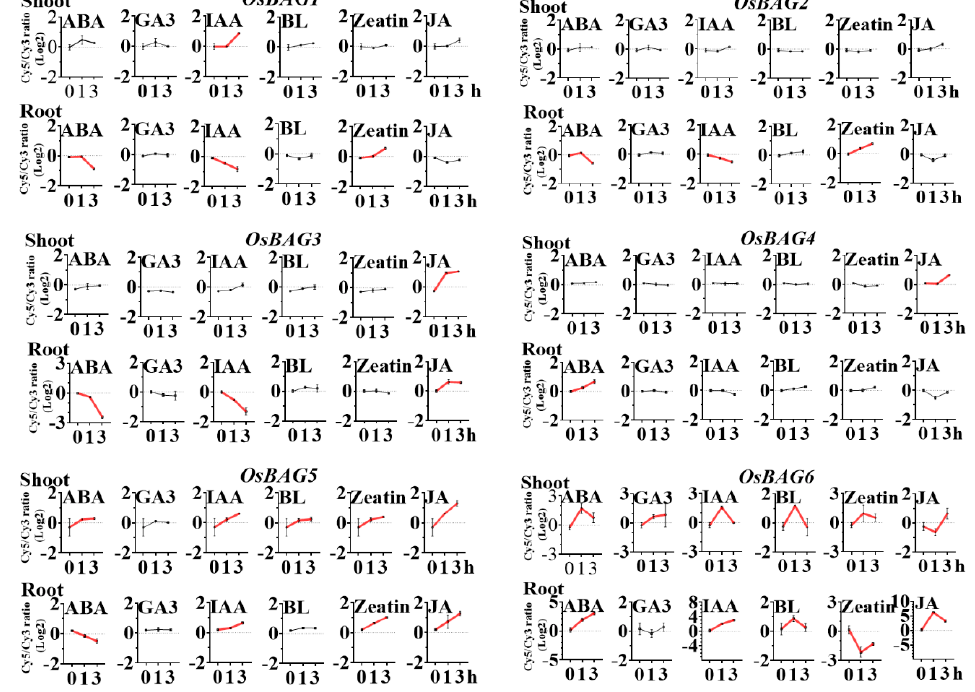
Figure 6. Expression profiles of OsBAG s in responses to plant hormones.